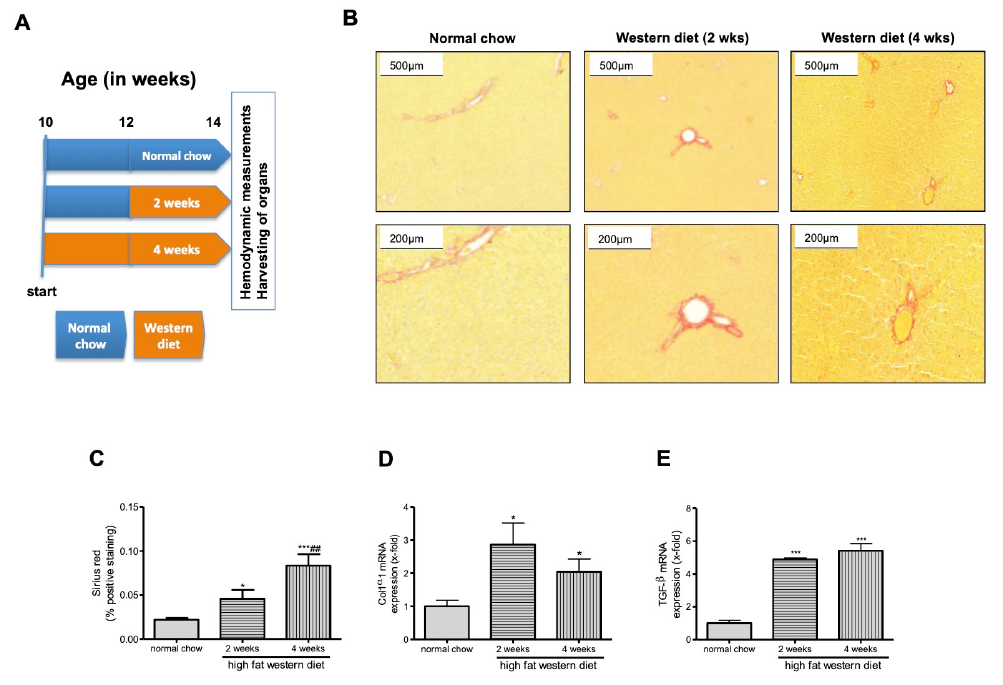
Figure 2. α -smooth muscle actin ( α -SMA) expression in transgenic TGR(mREN2)27 rats after high fat Western diet. ( A ) Hepatic α -SMA staining increased after 2 and 4 weeks of WD (left panel). ( B ) This